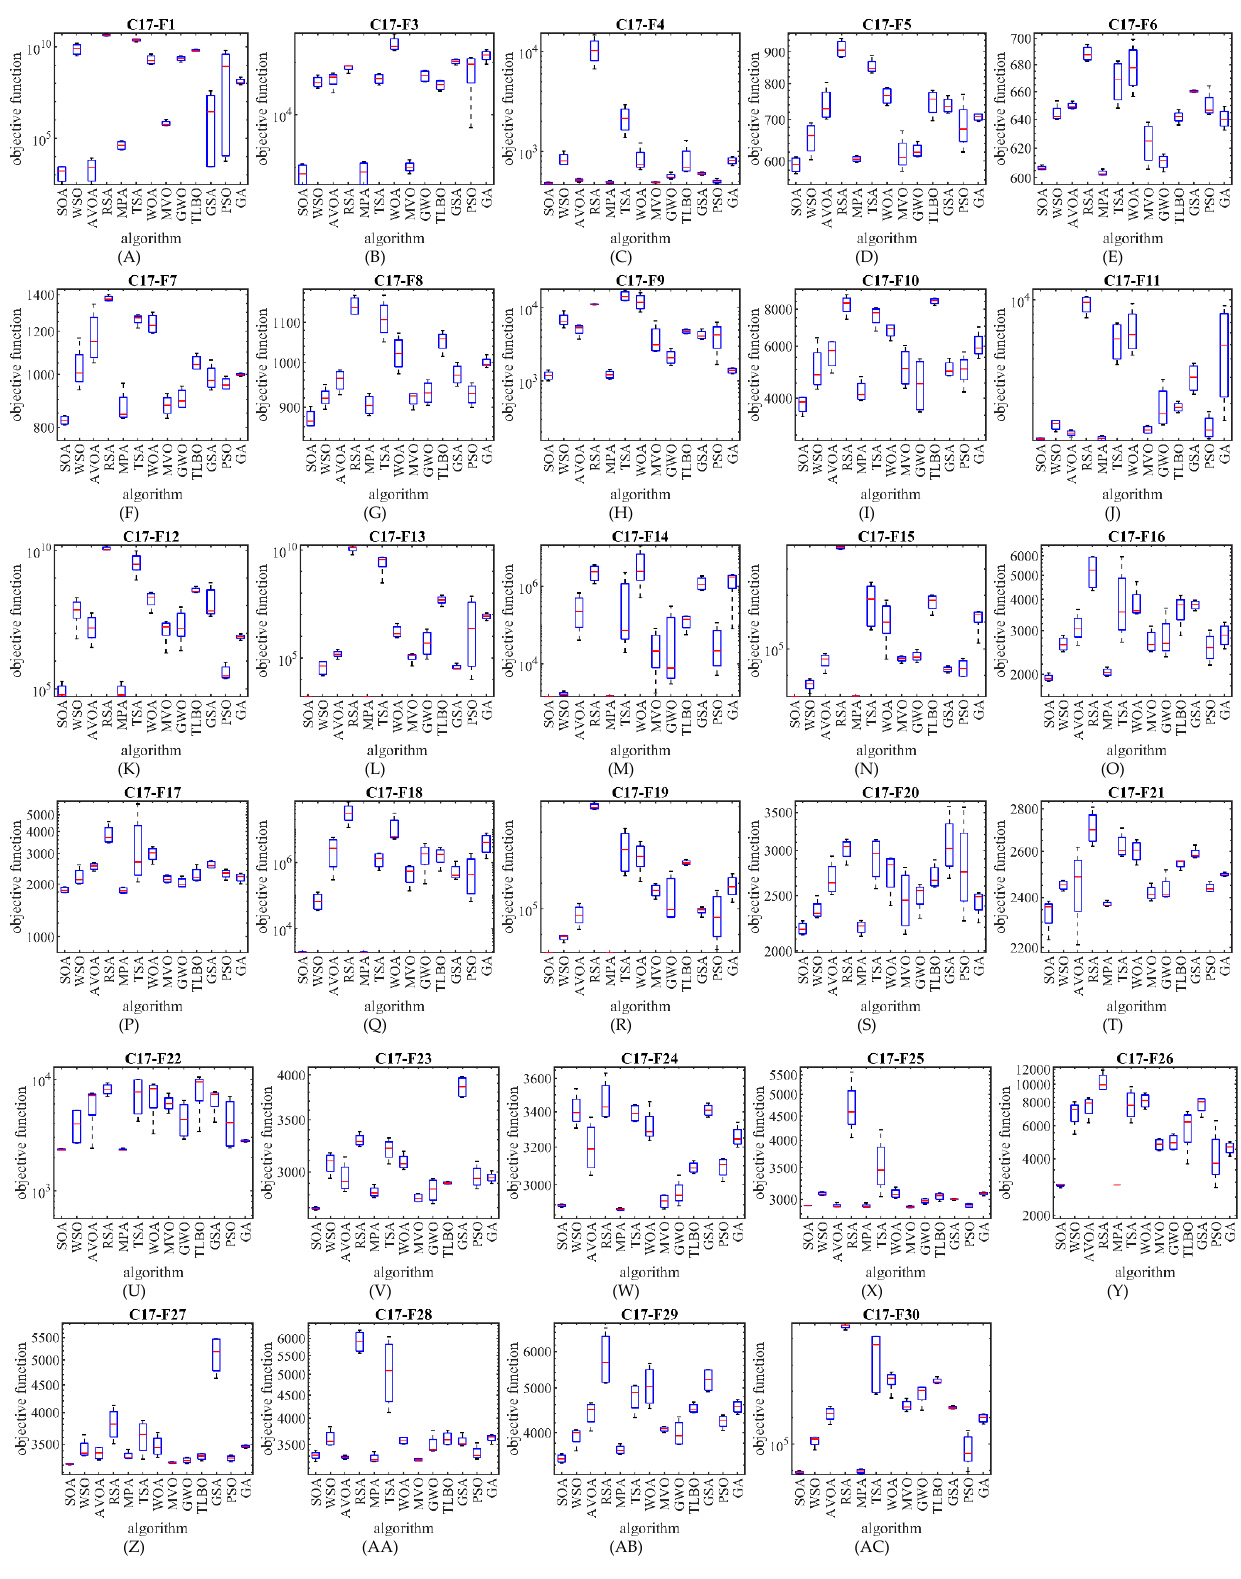
Figure 2. Boxplot diagram of SOA and competitor algorithms performances on the CEC 2017 test suite (for the dimension 𝑑 = 10 ).